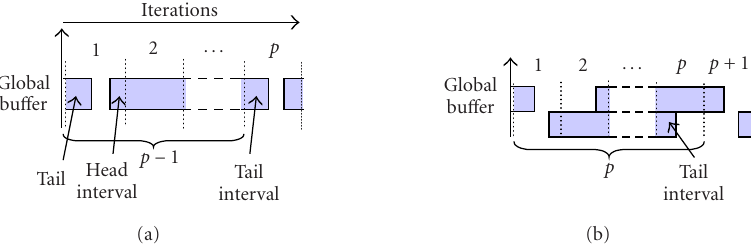
Figure 9: Illustration of a sample lifetime interval: (a) when the tail interval is mapped to the same global bu ff er as the head interval, and (b) when the tail interval is mapped to a di ff erent global bu ff er and there is no chained multicycle sample lifetime interval.